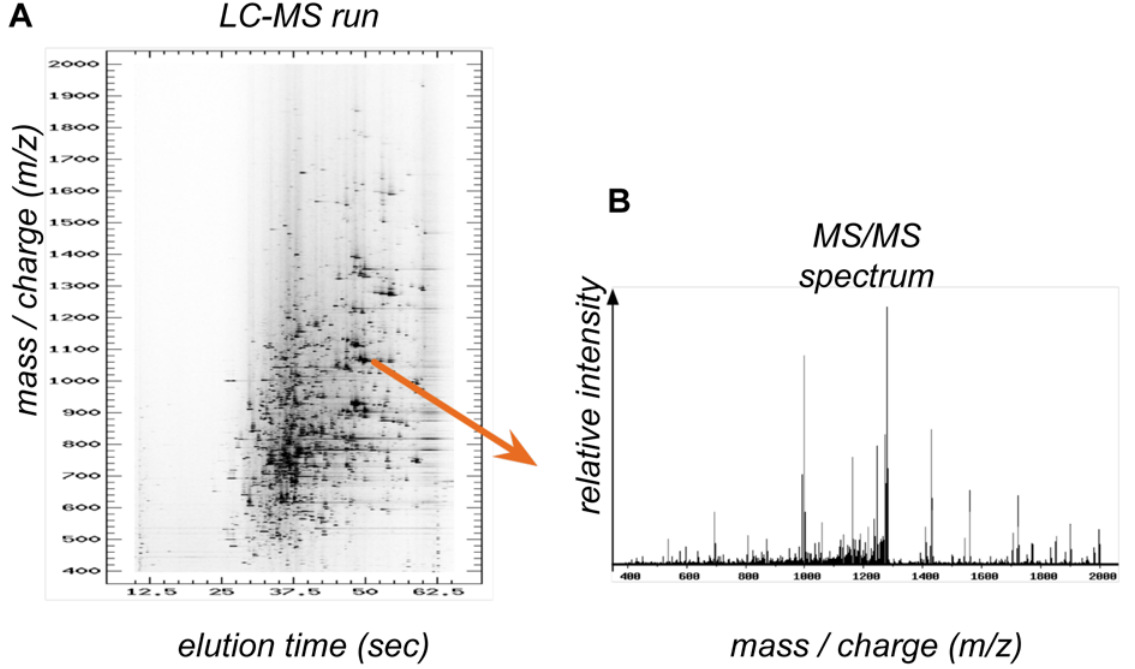
Figure 1. Example of spectral data. (A) LC-MS run. Features in the LC-MS space are peptide ions; their intensity is related to peptide abundance. (B) MS/MS spectrum. The spectrum is obtained by fragmenting the peptide ion isolated from an LC-MS peak. The peaks are fragment ions; distances between peaks are used for peptide sequence determination.